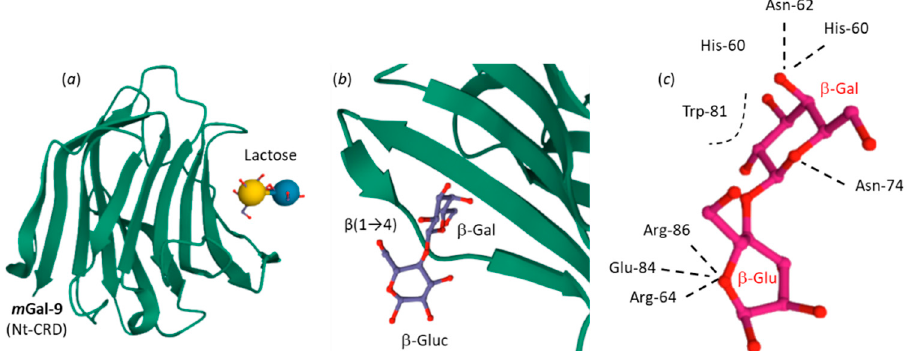
Figure 5. Crystal structure of mouse Gal-9 N-terminal CRD domain (NCRD) bound to lactose (PDB: 2D6M). ( a ) Lactose bound to mGal-9. ( b ) A close-up view of bound lactose. The β -galactoside moiety is deeply buried in the binding site formed by the juxtaposed β -strands. ( c ) Conformation of the bound lactose molecule and H-bonds formed with specific amino acid residues of mGal-9 [107].